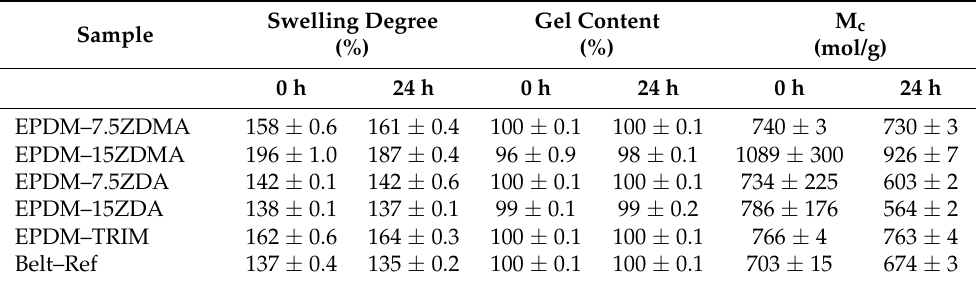
Table 4. Swelling degree, gel content, and cross-link density of EPDM compounds prior to and after post-curing for 24 h at 150 ◦